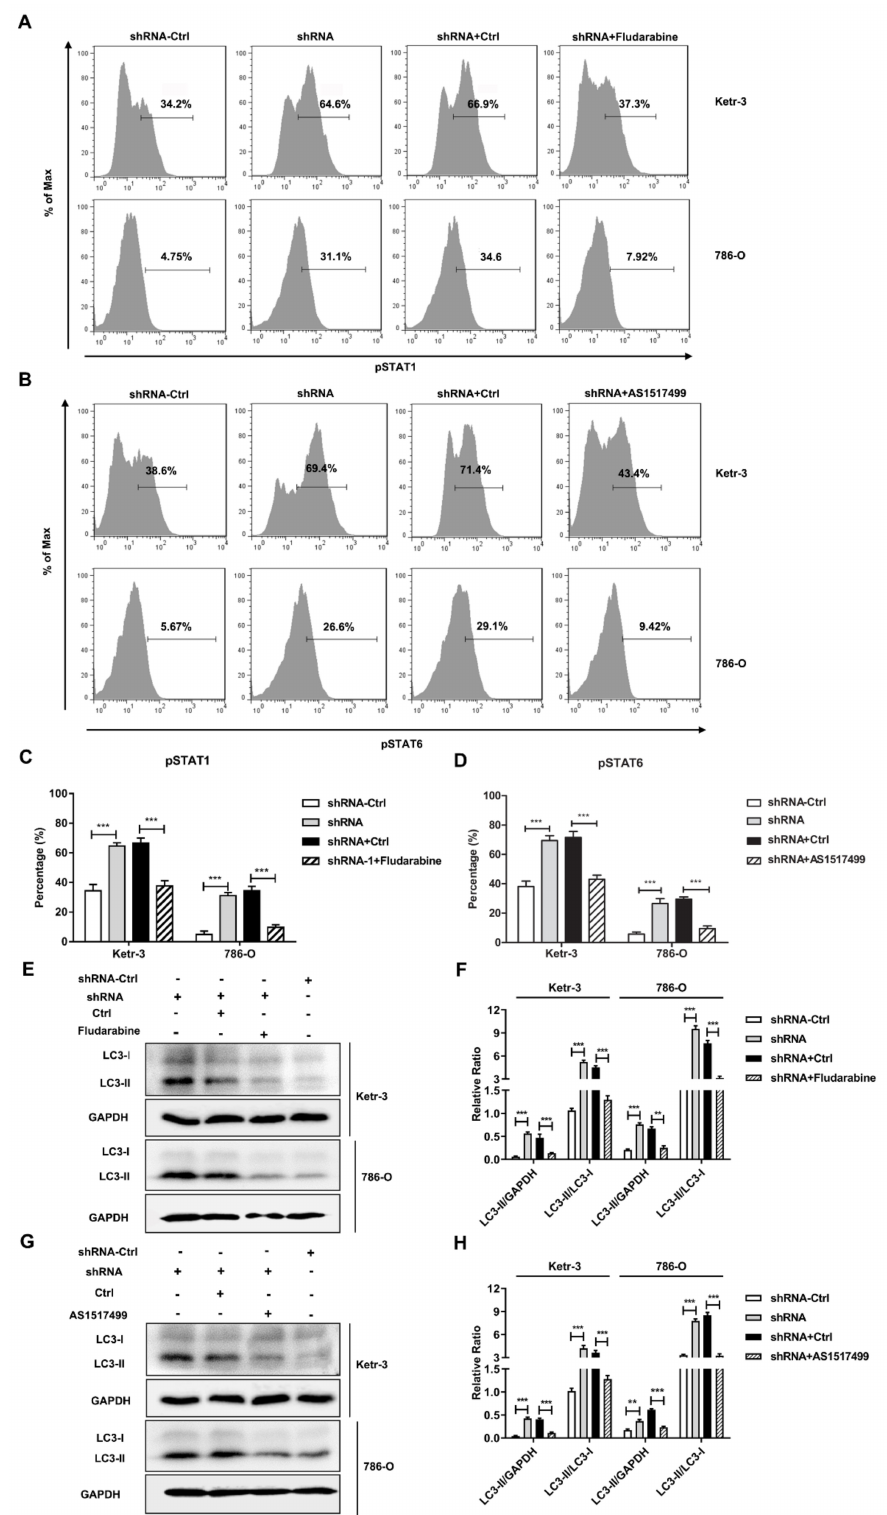
Figure 5. The autophagy induced by the IFI35 knockdown was dependent on the STAT1/STAT6 phosphorylation pathway in renal cancer cells. IFI35 knockdown Ketr-3 or 786-O cells were treated with or without inhibitor fludarabine (5 µ mol/L) or AS1517499 (100 nmol/L). ( A , B ) Forty-eight hours after inhibitor treatment, the levels of pSTAT1 or pSTAT6 were detected by flow cytometry in IFI35 knockdown renal cancer cells. ( C , D ) Statistical analysis of the levels of pSTAT1 or pSTAT6 was